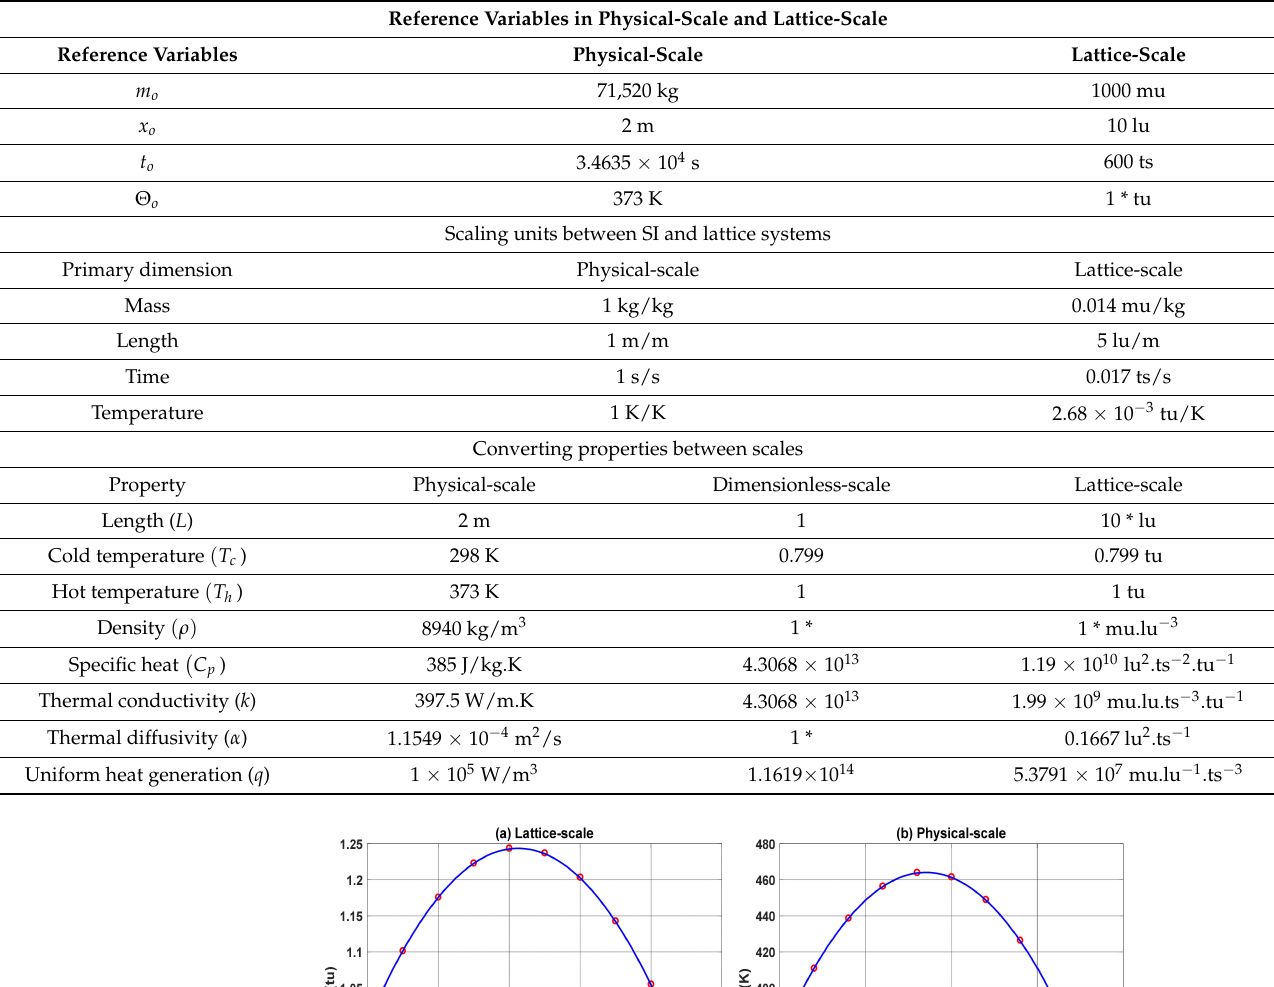
Table 4. Converting data for diffusion problem. The values with * represent assumed values.